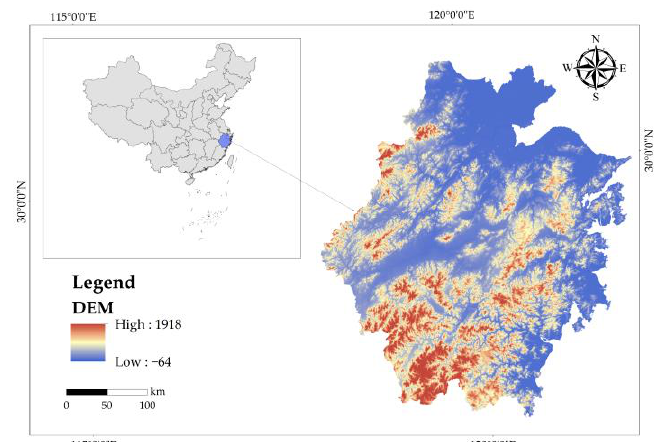
Figure 1. The study area.